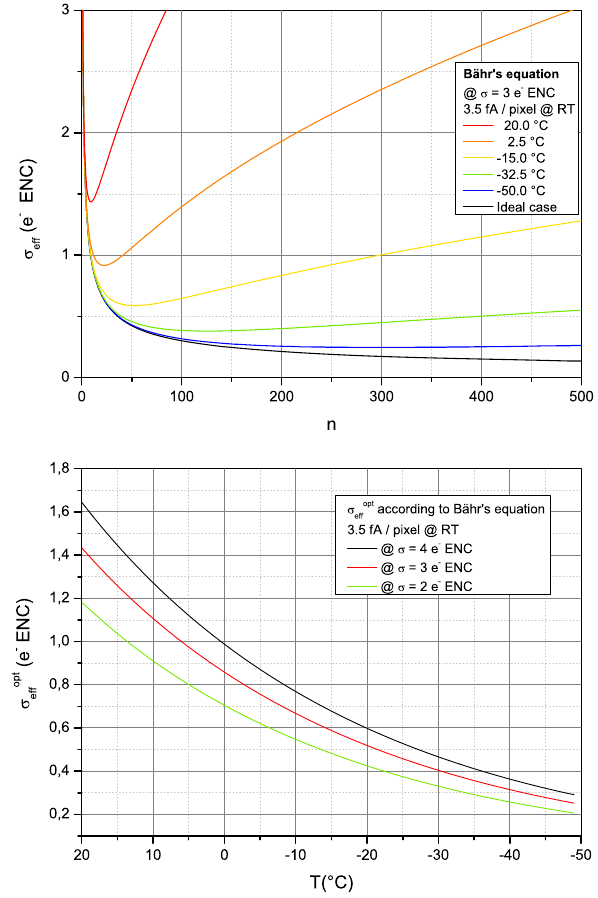
Fig. 5 Example performance graphs according to Bähr’s equation: Dependence of σ eff on n and temperature for a pixel with 3 e − ENC (top) and dependence of σ opt on temperature for three different initial eff sigma